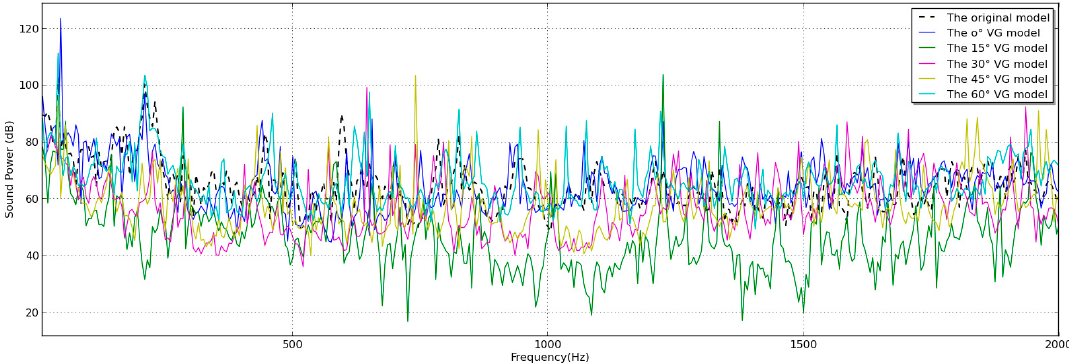
Figure 9. The comparison curve of radiated sound power from the original model and the model with triangular VGs at different angles to the flow direction. ‘The 0 ◦ VG’ means that the triangular VGs are at the angle of 0 ◦ to the flow direction. The other meanings are the same as ‘The 0 ◦ VG’.